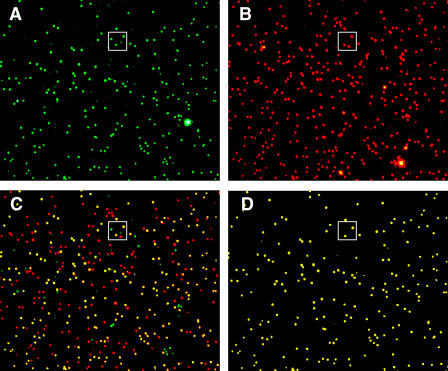
Data Collection and Processing for Digital Images Obtained from a Single Diluted Whole Blood Specimen from an HIV-Infected ParticipantA total of 16.5 μl of whole blood stained with antibodies specific for CD4 and CD3 markers is delivered to the flow cell after 8 min, and an image of the same region of the membrane is obtained with two different emission filters.(A) AlexaFluor-488-conjugated anti-CD4 antibody stains CD4+ cells (T lymphocytes and monocytes) green.(B) AlexaFluor-647-conjugated anti-CD3 antibody stains CD3+ T lymphocytes red.(C) By digitally merging the two images, CD3+CD4+ T lymphocytes (i.e., “CD4 cells”) appear yellow and are distinguished from CD4+CD3− monocytes (green) and CD3+CD4− T lymphocytes (red).(D) A lymphocyte selection algorithm is applied to the merged image, based on a lymphocyte profile as defined by size, shape, and uniformity. Objects not fitting the lymphocyte profile are deleted while remaining objects are selected and ultimately counted. A similar protocol to count CD8 cells is used in each participant.Boxed region indicates two CD4+ cells (yellow in [C]) in the original (A and B), merged (C), and processed (D) images. Large green and red objects seen in some images represent aggregates of fluorescent antibody.